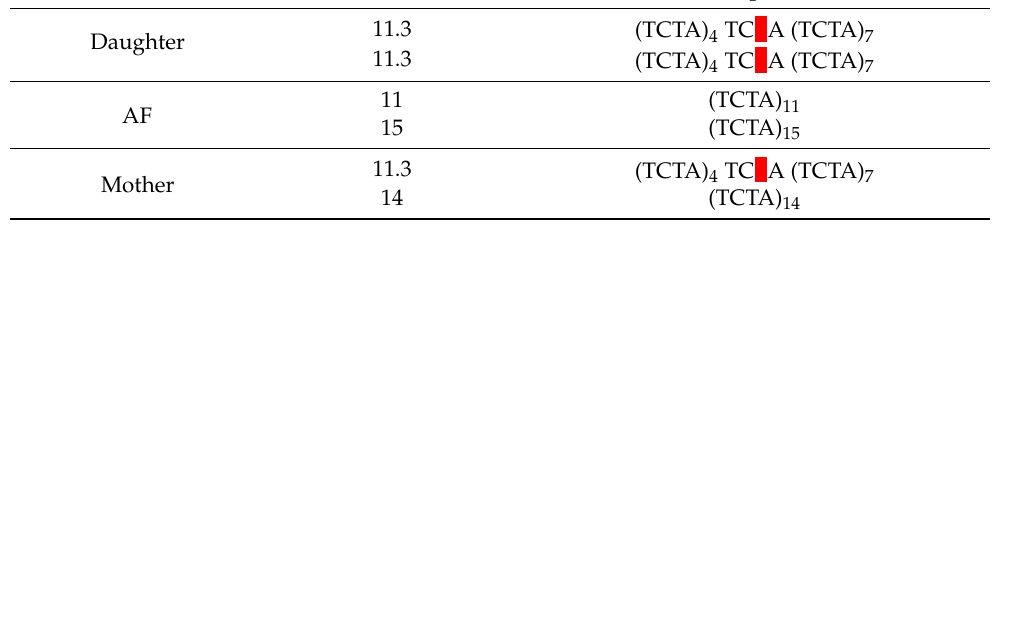
Table 3. Allele nucleotide sequences of marker D2S441 with highlighted single nucleotide